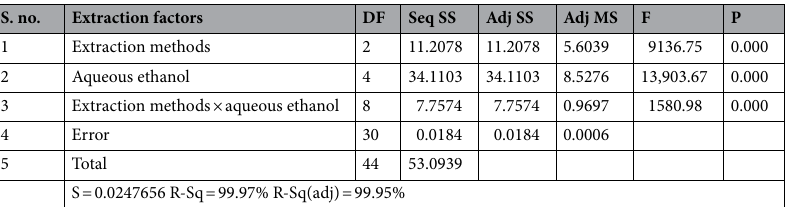
Table 4. Analysis of Variance for solvents and extraction techniques on mangiferin yield from Swertia chirata leaves.